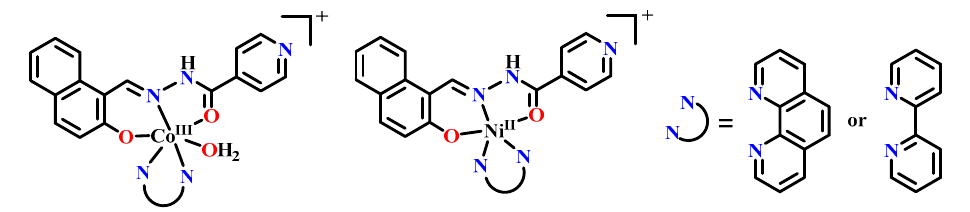
Figure 3. The Co(III)/Ni(II) complexes of NIH (2-hydroxy-1-naphthaldehyde isonicotinoyl hydra- zone).